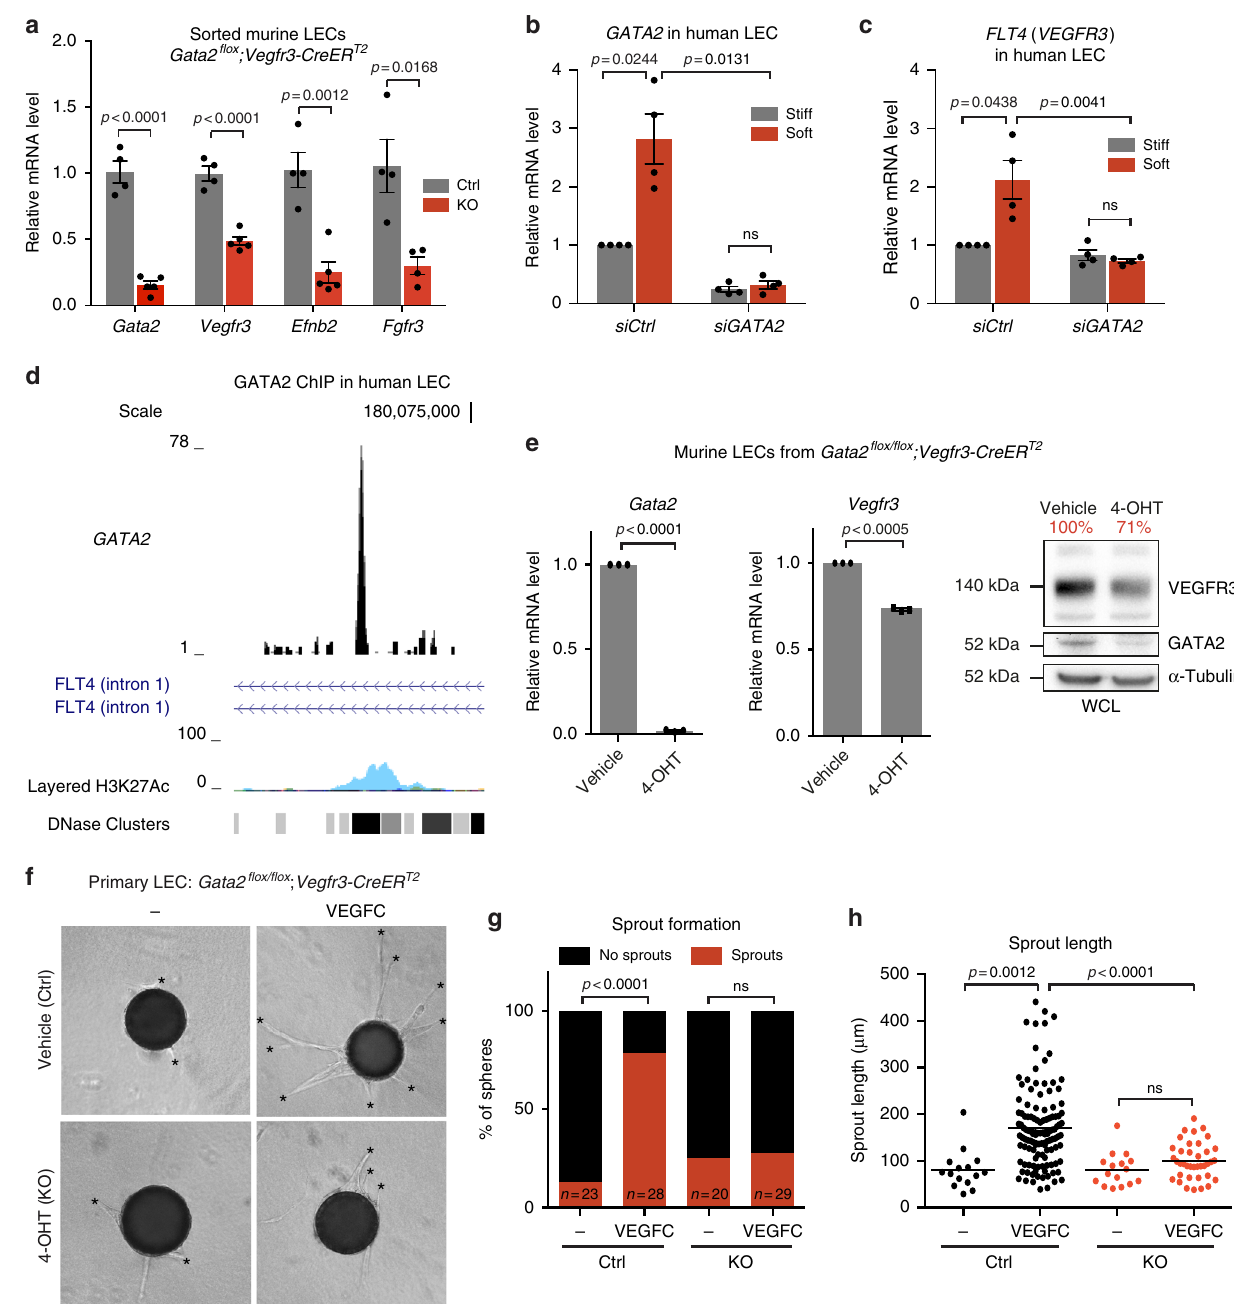
Fig. 5 GATA2 regulates VEGFR3 expression and LEC responsiveness to VEGF-C. a Relative mRNA expression levels of Gata2 , Vegfr3, Efnb2 and Fgfr3 in freshly isolated LECs from E15.5 Gata2 mutant ( n = 4 or n = 5) and Cre − littermate control ( n = 4) embryos. Horizontal lines represent mea n ± s.e.m. p value, unpaired Student ’ s t -test. b , c qRT-PCR analysis of GATA2 and VEGFR3 in control (Ctrl) and GATA2 siRNA-treated human LECs grown on soft (0.2 kPa) or stiff (25 kPa) matrix. n = 4 experiments, mean ± s.e.m. p value, one-sample t -test (for siCtrl stiff vs soft) or unpaired Student ’ s t -test. d Occupancy of chromatin at the FLT4 (encoding VEGFR3) locus as viewed in UCSC Human Genome Browser (http://genome.ucsc.edu/). GATA2 ChIP-seq pro fi le demonstrating binding at the fi rst intron of the FLT4 locus in human dermal LECs. Co-occupancy with H3K27Ac and sites of DNase hypersensitivity, both marks of active enhancer elements, are shown in ENCODE tracks (HUVEC, light blue peaks). e qRT-PCR and western blot analysis of Gata2 and Vegfr3 in control and 4-OHT treated ( Gata2 deleted) primary mouse LECs. For qRT-PCR: n = 3 experiments, mean ± s.e.m. p value, one-sample t -test. Main band (125 kDa) quanti fi cation is shown in red. f Vehicle (Ctrl) and 4-OHT (KO) treated primary mouse LEC spheres in the absence ( − ) or presence of VEGF-C. Asterisks indicate sprouts. g Proportion of control (Ctrl) and Gata2 de fi cient (KO) LEC spheres forming sprouts in the absence ( − ) or presence of VEGF-C. n is indicated; p value, Fisher ’ s exact test. h Quanti fi cation of sprout length. Dots represent individual sprouts. Horizontal lines represent mean. n = 20 – 30 beads (from two independent experiments). p value, unpaired Student ’ s t